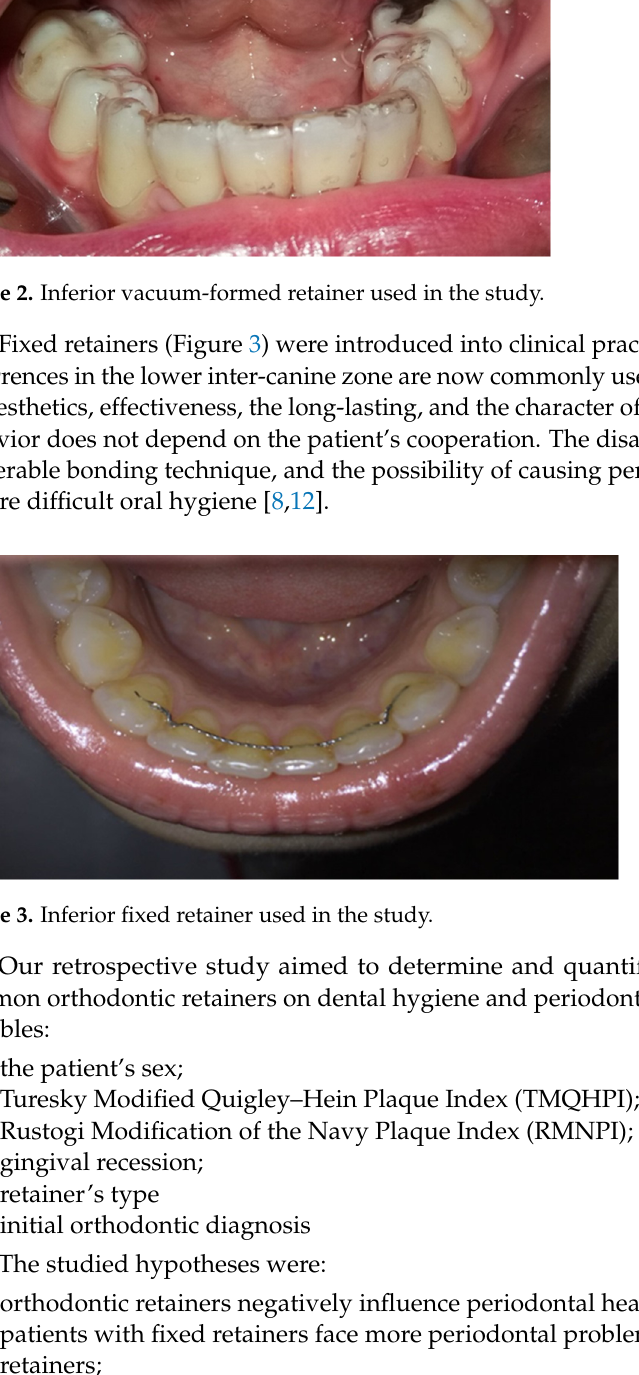
Figure 1. Hawley retainer used in the study.